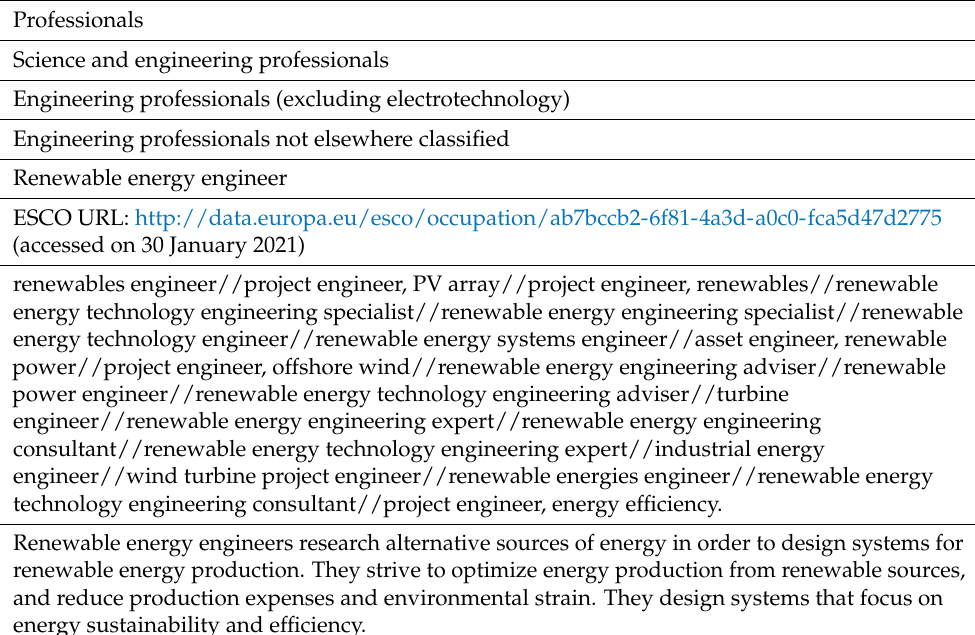
Table 5. Sample job profile tab from the